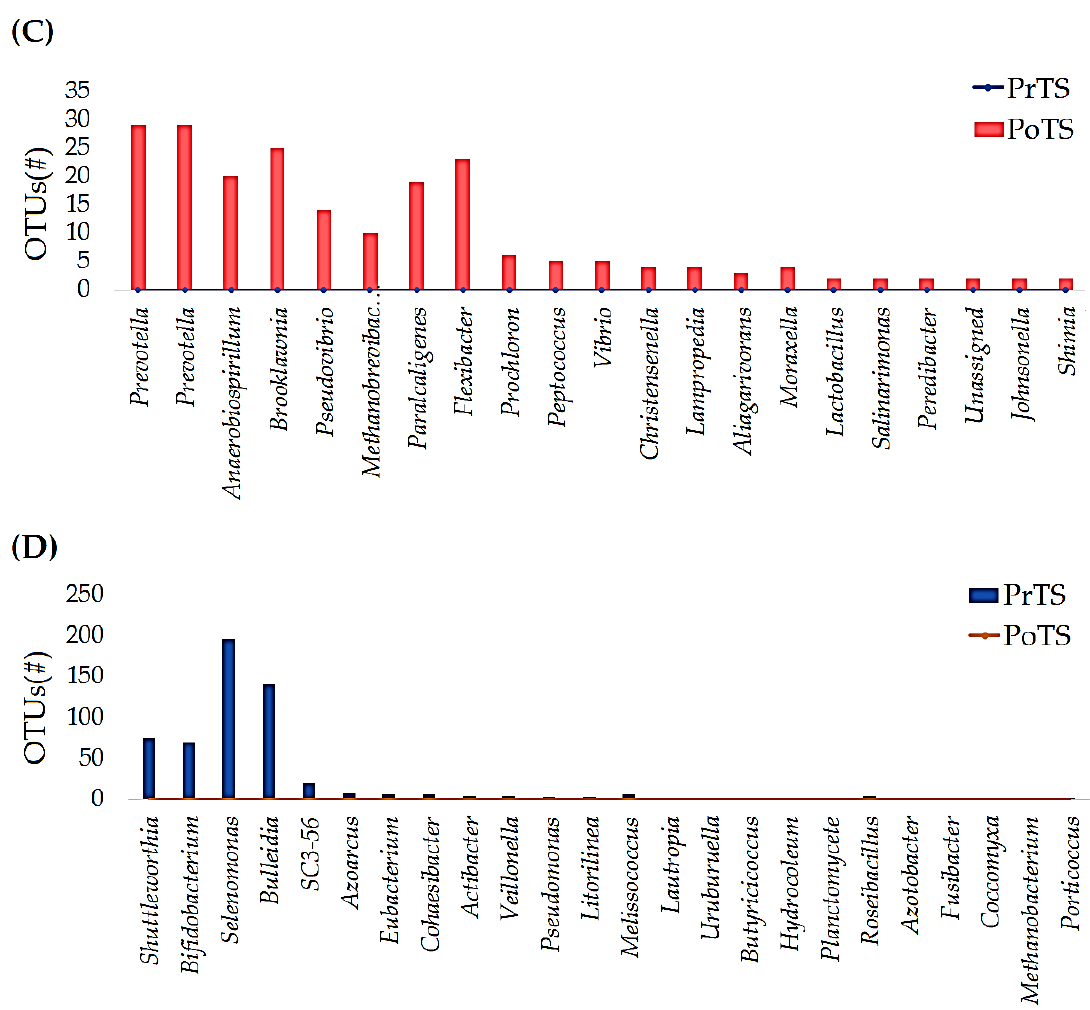
Figure 4. Comparison of the genus-level relative frequency of the PrTS and PoTS of G1. The reduced ( A ), increased ( B ), newly evolved ( C ), and completely vanished ( D ) genera in the control group after 42 days of study were reported. PrTS: pretreatment samples; PoTS: post-treatment samples.